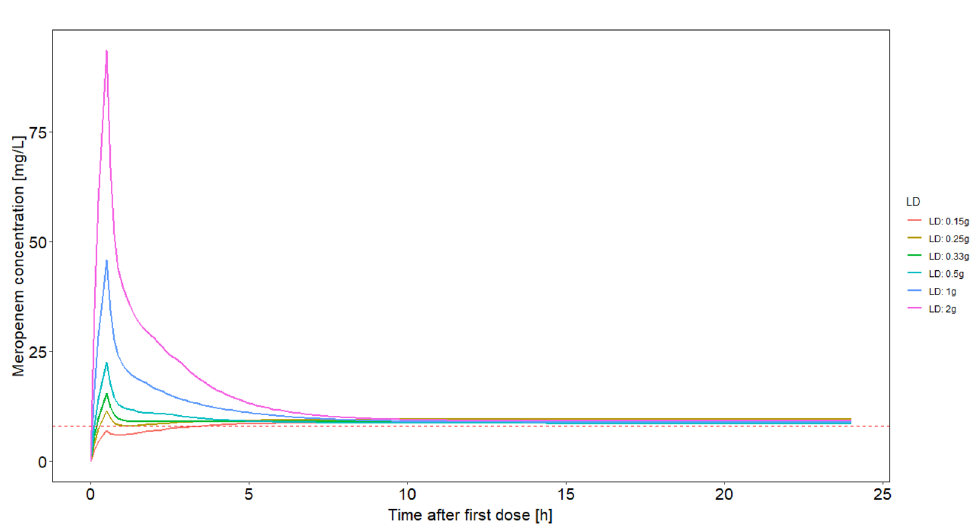
Figure 2. Predicted plasma concentration–time profile (5 th percentile) in a patient with a creatinine clearance of 80 mL/min and varying loading doses. Albumin was fixed to 2.8 g/dL, body weight was fixed to 70 kg. A daily dose of 3 g was administered. Lines: 5th percentile of the concentration time profile, Horizontal dotted line: 4 × S/I breakpoint of Pseudomonas aeruginosa according to 12 . LD: loading